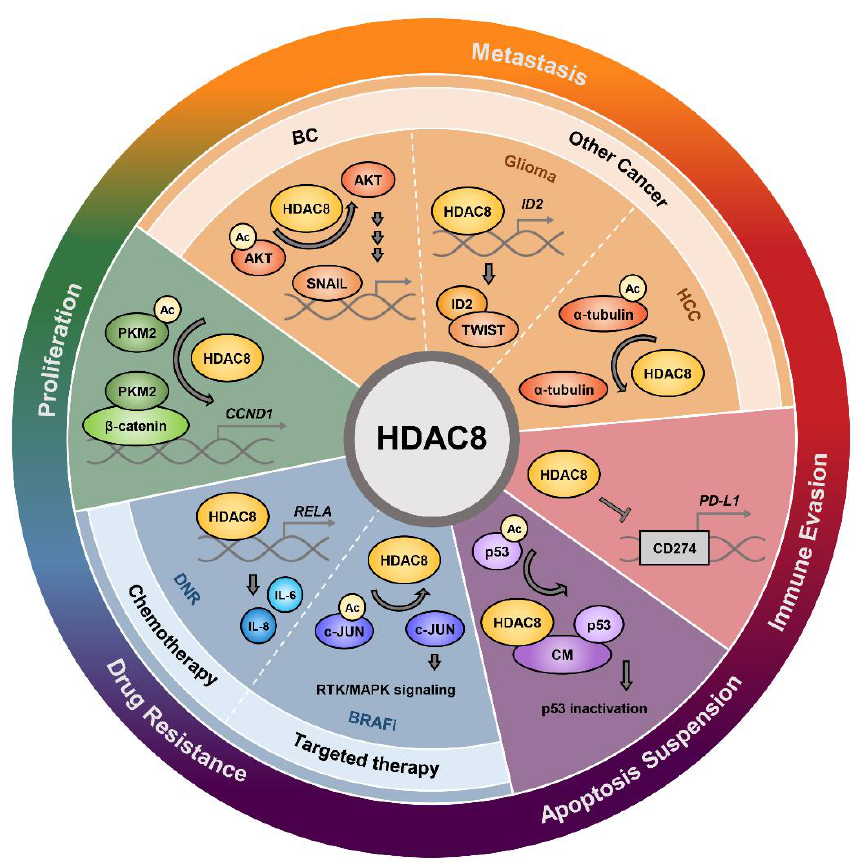
Figure 4. Schematic representation of pathological functions of HDAC8 in cancer. HDAC8 promotes tumor growth by enhancing tumor cell proliferation and suppressing apoptosis. HDAC8 also enhances metastasis and is involved in drug resistance and immune evasion.